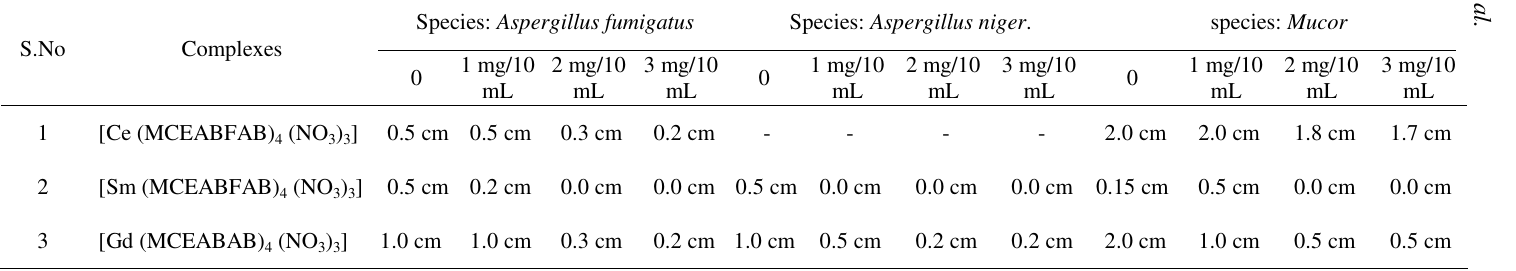
Table 9. Antibacterial activities of some of the representative complexes of lanthanide(III) metal ions with Schiff base ligands (After 48 hours of